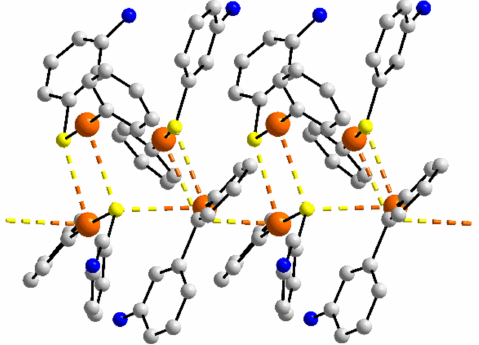
Figure 16. Supramolecular association in a zigzag chain in 45 featuring three independent Hg ··· S interactions. The amino-H atoms were not located in the original study and hence, are not